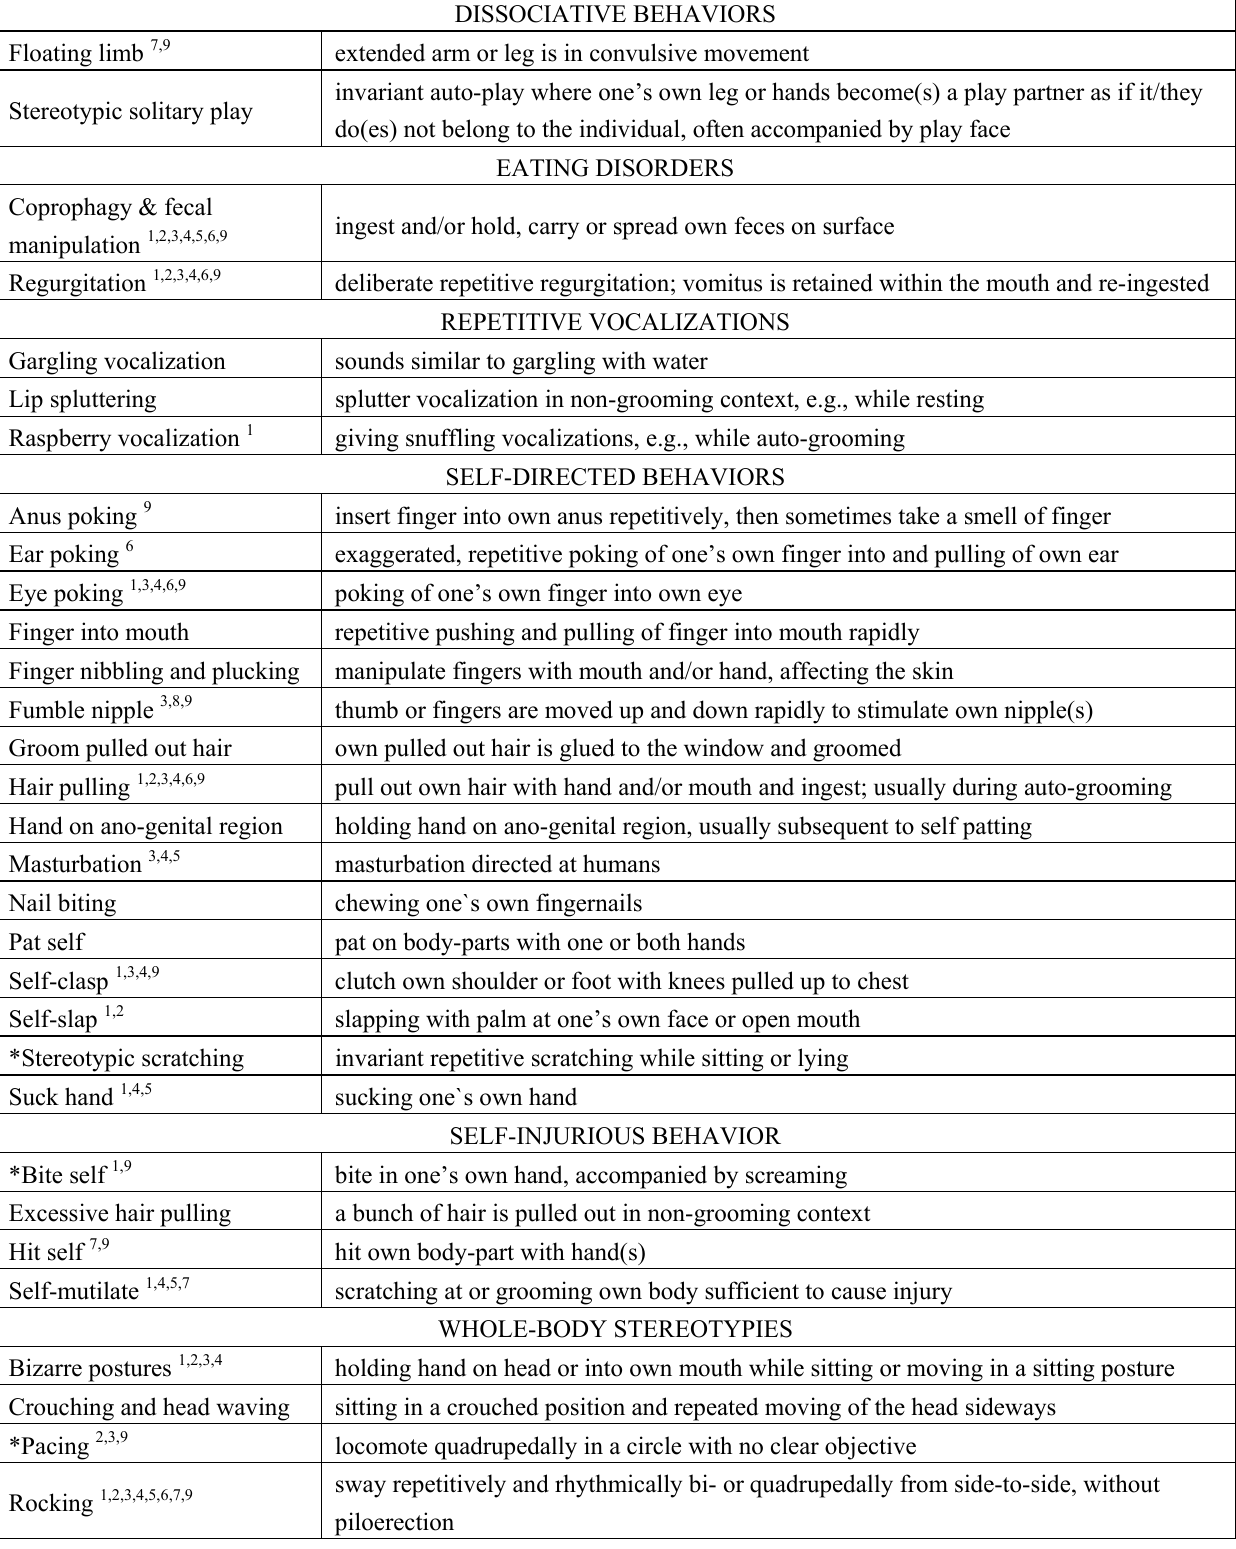
Table 1. Ethogram of abnormal behavior patterns observed in this study